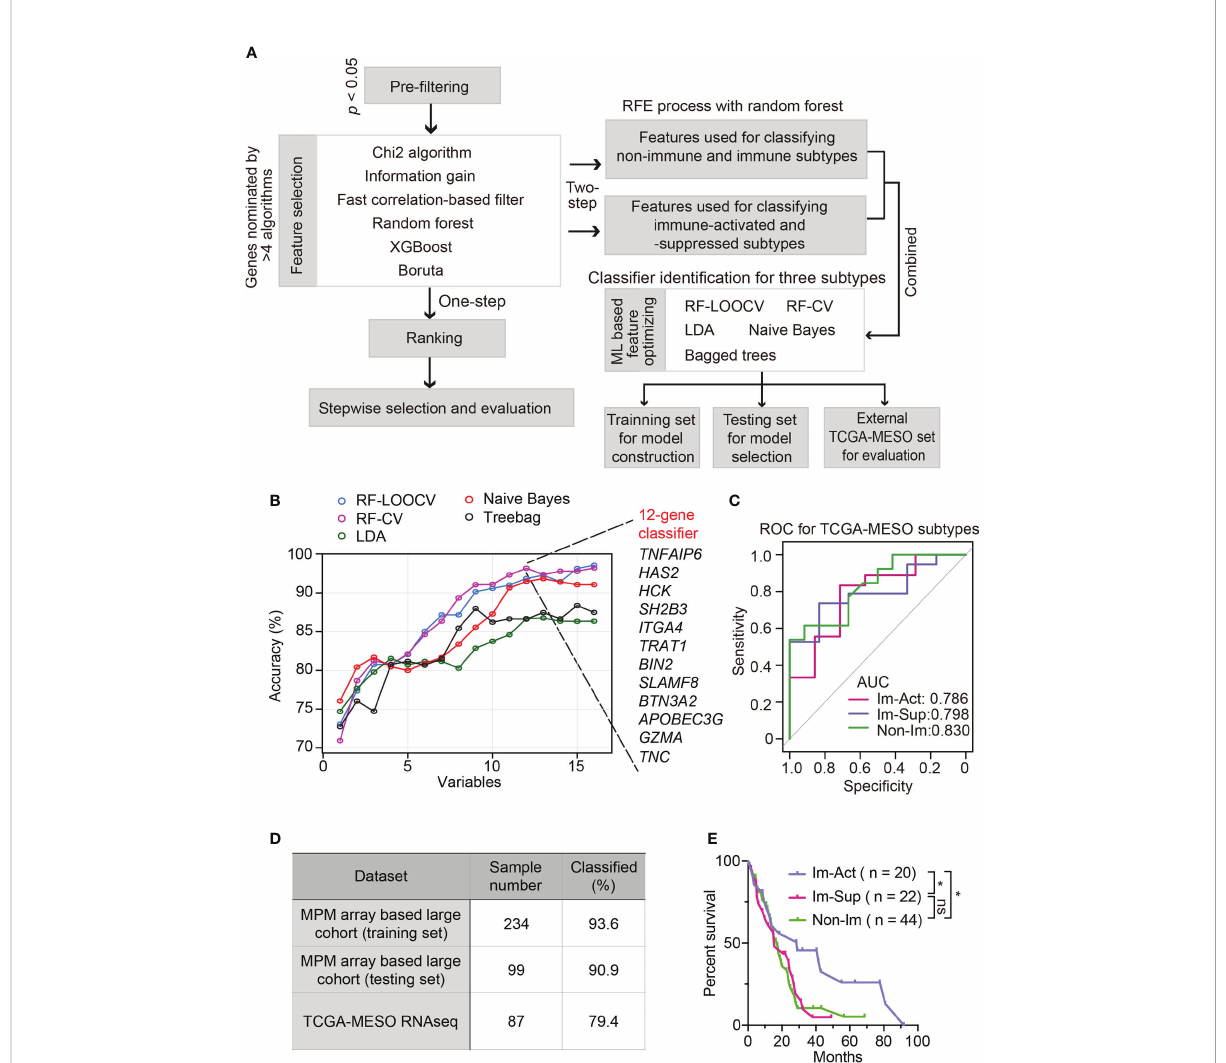
FIGURE 5 Development and validation of robust classi fi ers for distinguishing three subtypes of MPMs. (A) The work fl ow of a multi-step procedure for identifying classi fi ers to distinguish three immune subtypes of MPMs. LDA, Linear discriminant analysis; CV, Cross-validation; LOOCV, Leave- one-out cross-validation; ML, Machine learning. (B) Line graphs illustrate the variation trend of classi fi cation accuracy computed by multiple feature selection algorithms plus stepwise recursive feature elimination (RFE) process. The x-axis suggested a different number of variable combinations. (C) Receiver operating characteristic (ROC) curves of the 12-gene classi fi er for classifying each immune subtype separately. The scores of the area under curve (AUC) are presented in the plot. (D) Percentage of correctly classi fi ed samples using the 12-gene classi fi er